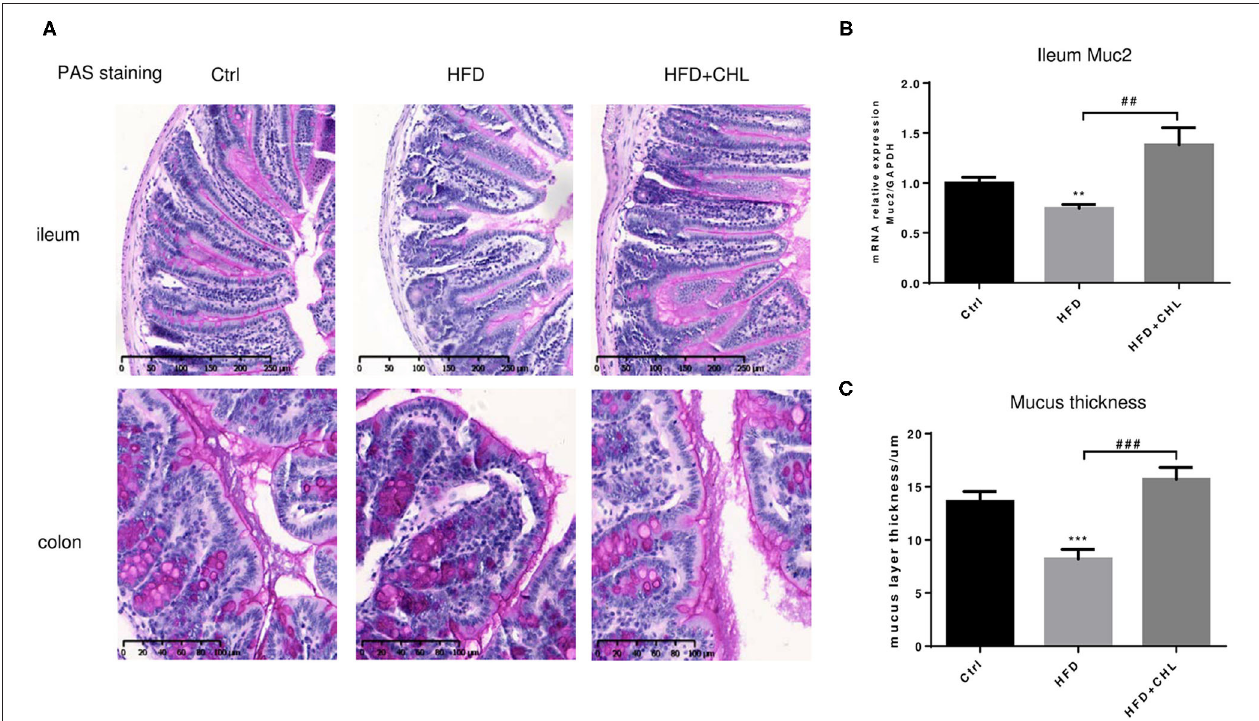
FIGURE 9 | CHL improves the small intestinal mucus of the mice fed with an HFD. (A) The experimental condition is described in Figure 1 . Periodic acid–Schiff (PAS) staining of the ileum and colon. (B) Muc2 expression in the ileum was determined by RT-qPCR analysis. (C) The thickness of mucus layers of the ileum, as an average of three views for each mouse. Values are mean ± SEM; ** p < 0.01, *** p < 0.001 vs. Ctrl group; ## p < 0.01, ### p < 0.001 vs. HFD